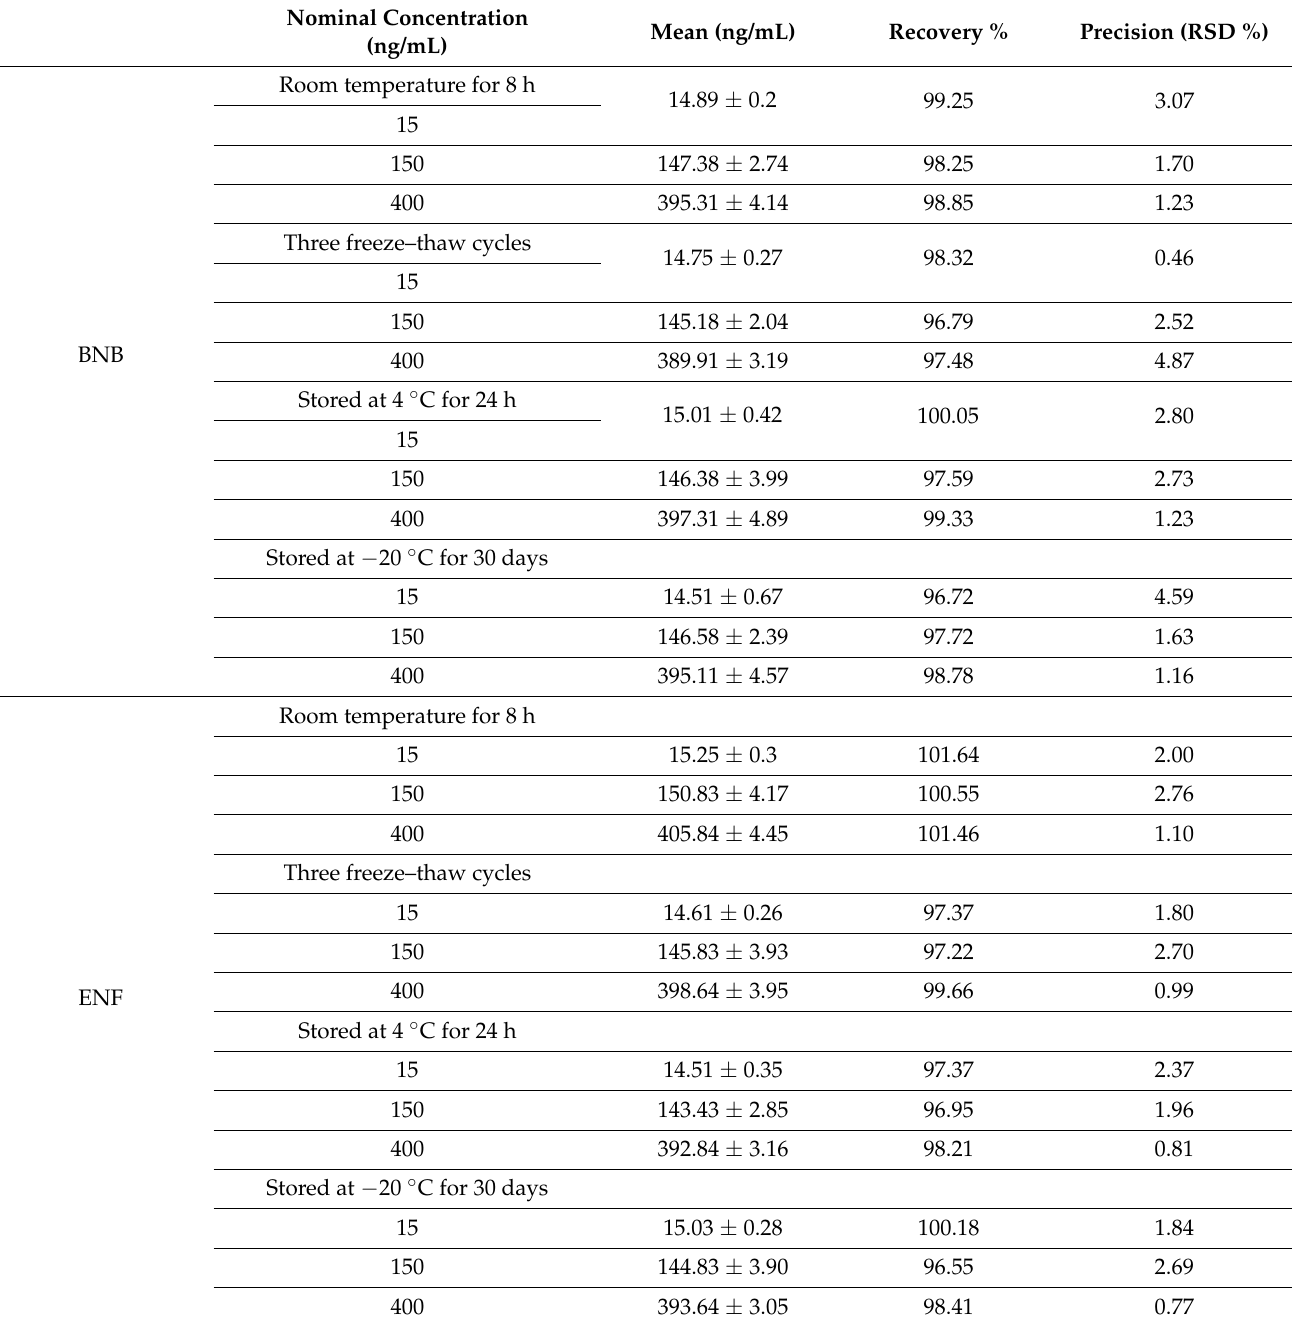
Table 4. Stability of ENF and BNB in the HLM matrix (1 mg/1 mL phosphate buffer) under different laboratory